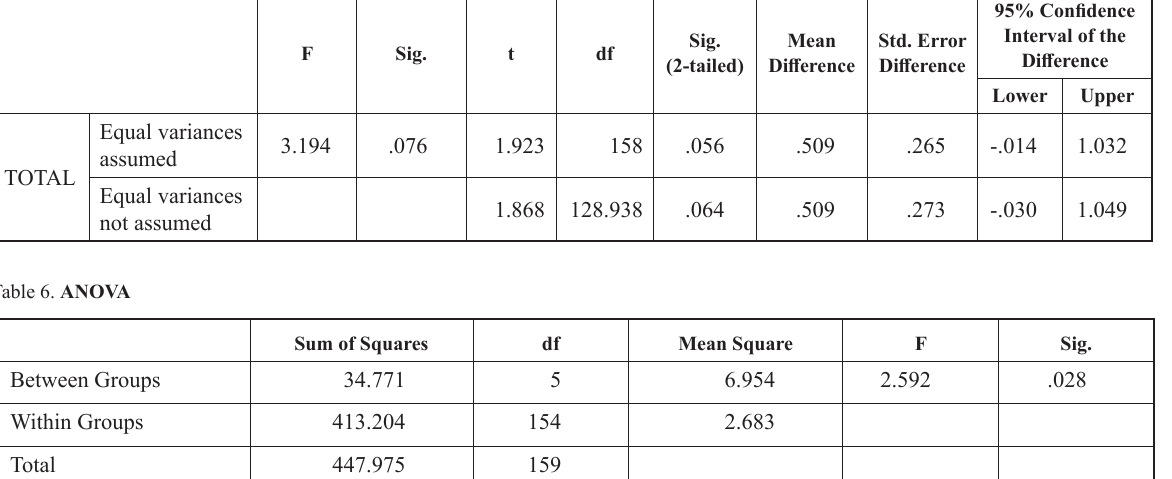
Levene’s Test for Equality of Variances